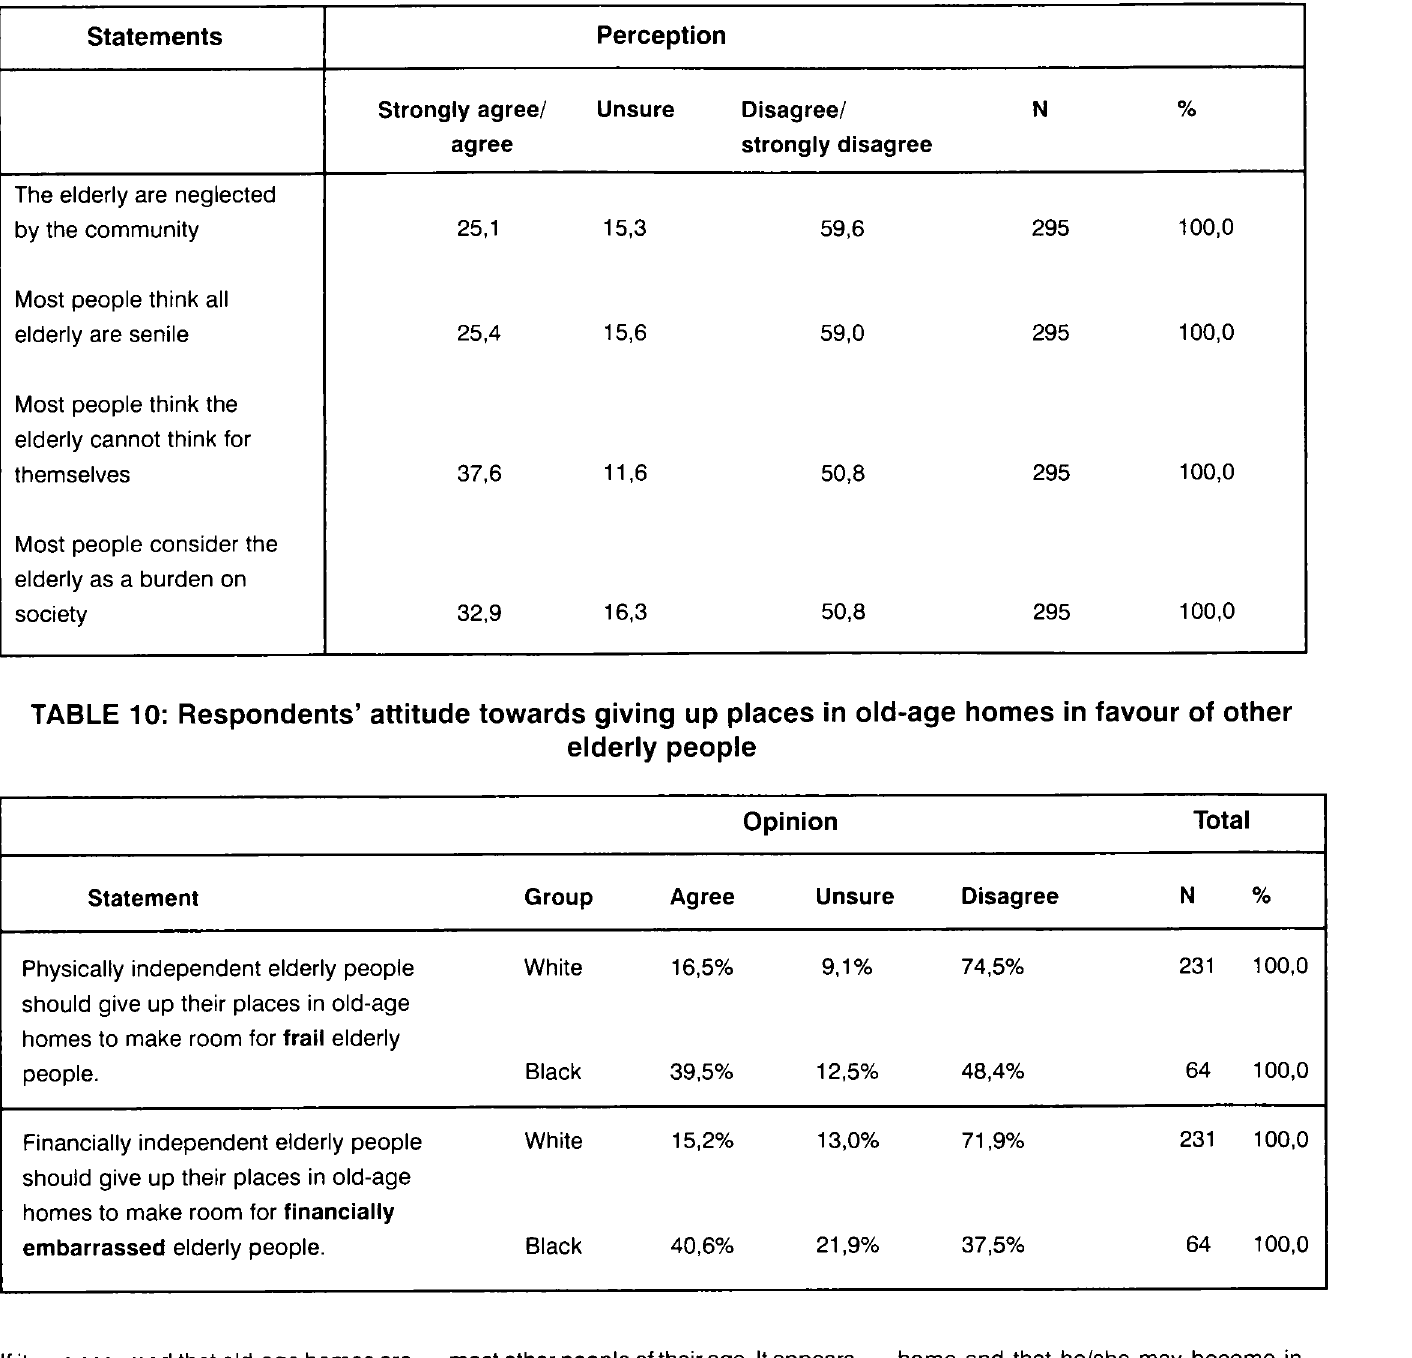
TABLE 10: Respondents’ attitude towards giving up places in old-age homes in favour of other elderly